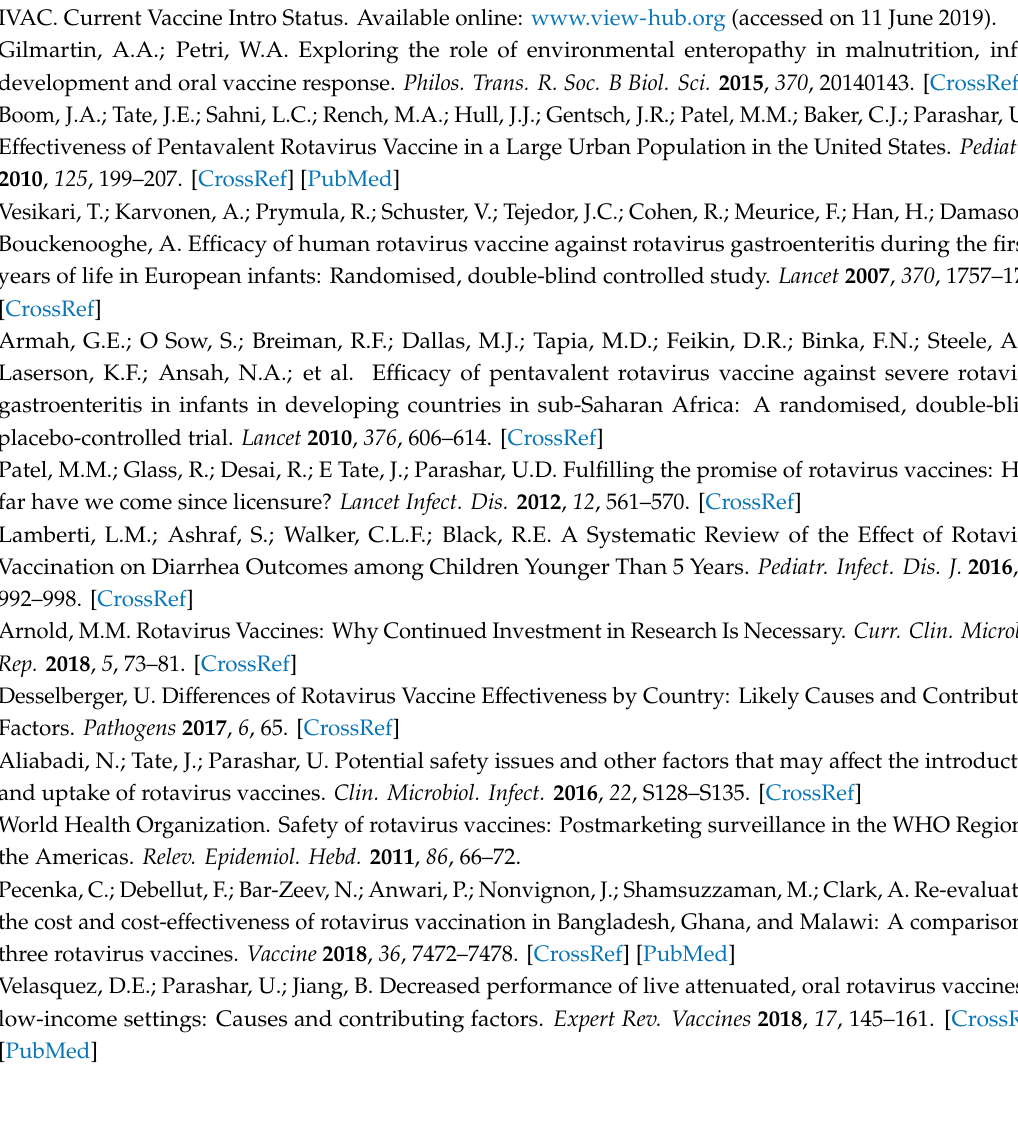
Figure S1: Negative stain TEM images of P24-VP8* particles. Figure S2: Geometric mean VP8*-specific IgG titers in SIC of Gn